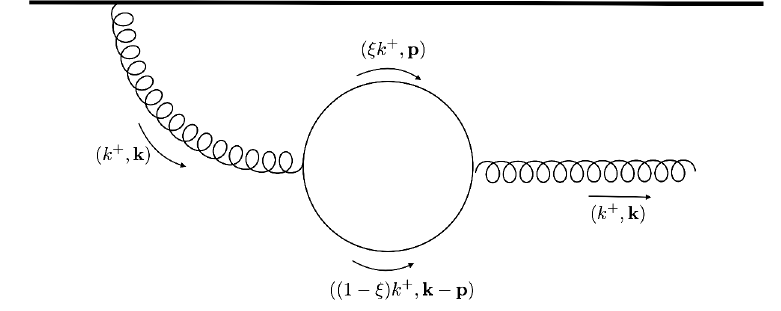
Figure 2. Quark loop correction for the single gluon emission diagram; ξ is the defined as ξ ≡ p + / k + . The horizontal thick line is the valence